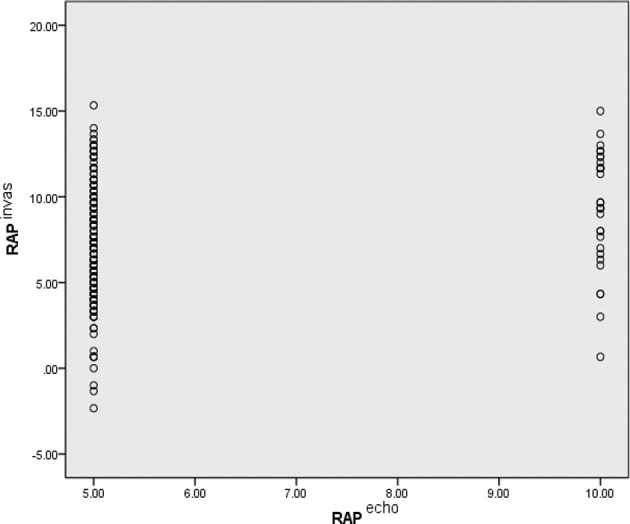
Comparison of RAP as estimated by D-ECHO and RHC. Echo, measured by Doppler echocardiographic; invas, invasive measurement by RHC; RAP, right atrial pressure.